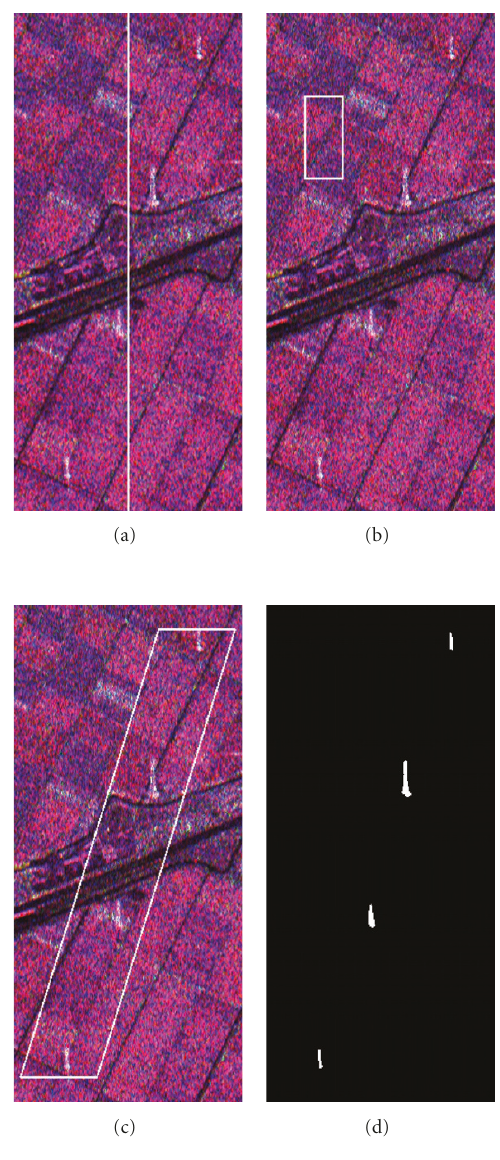
Figure 7: Segmentation result on a PiSAR image with di ff erent initialization size: 498 × 213. α = 10, μ = 72 . 6. (a)–(c) Three di ff erent initializations. (d) Segmentation result.